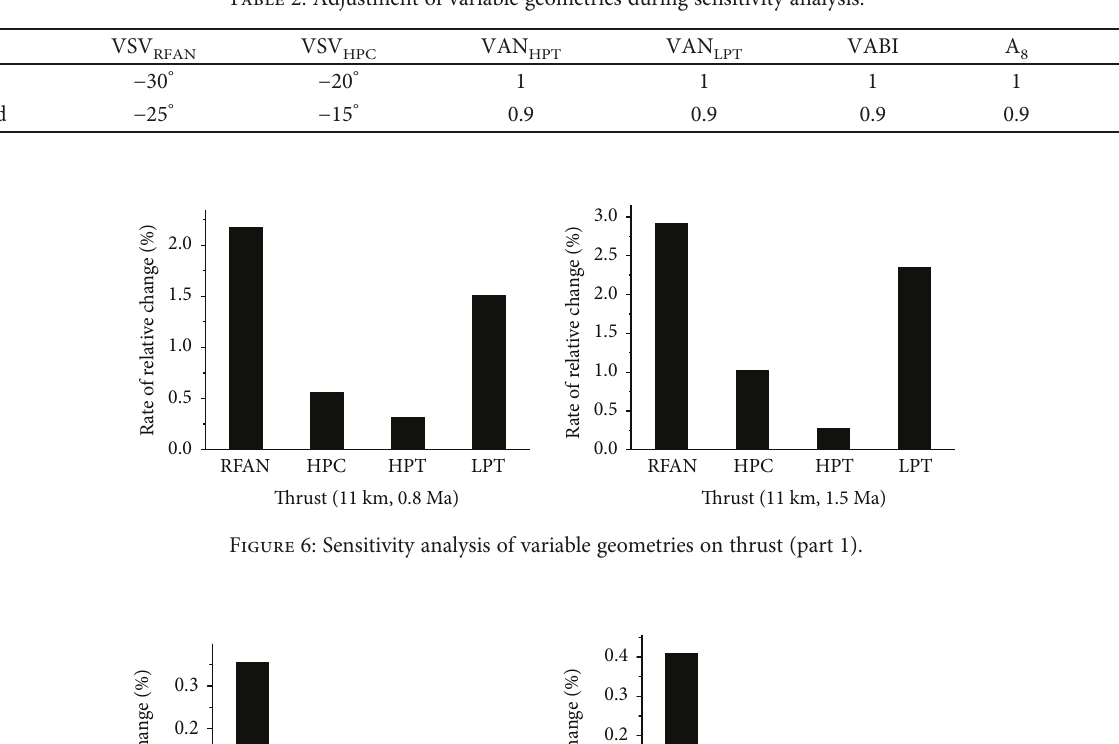
Table 2: Adjustment of variable geometries during sensitivity analysis.